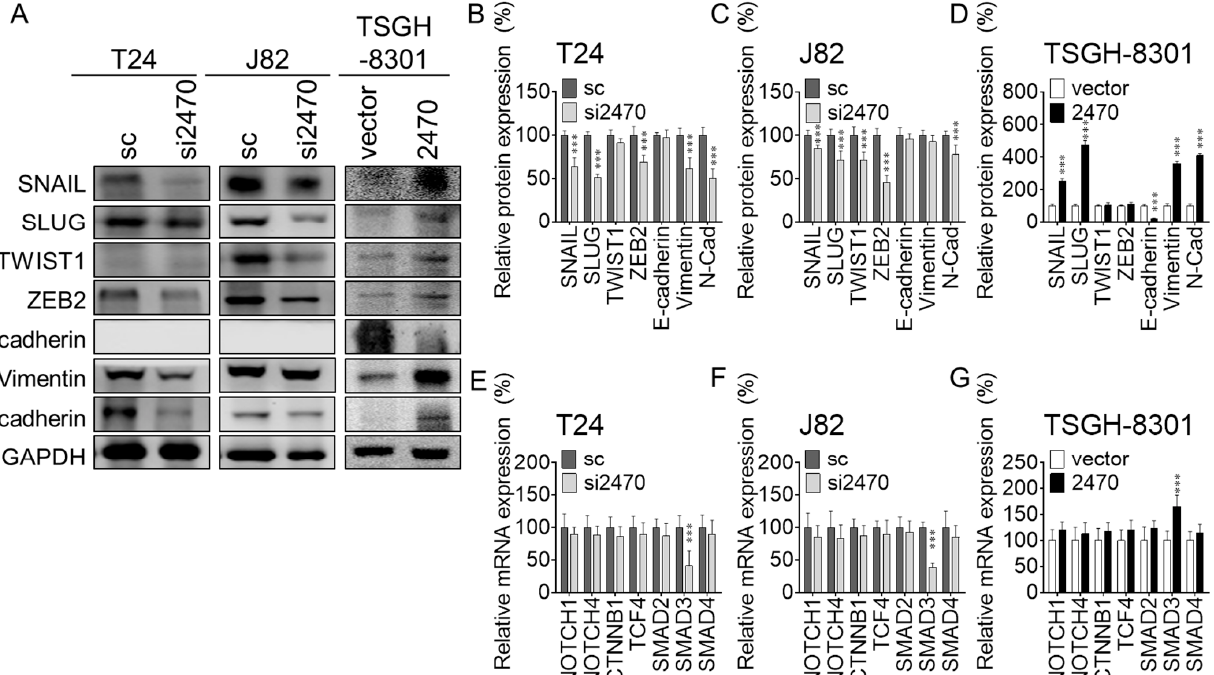
Commented [M11]: The gene name of Figure 3A was cutted off and should be corrected.